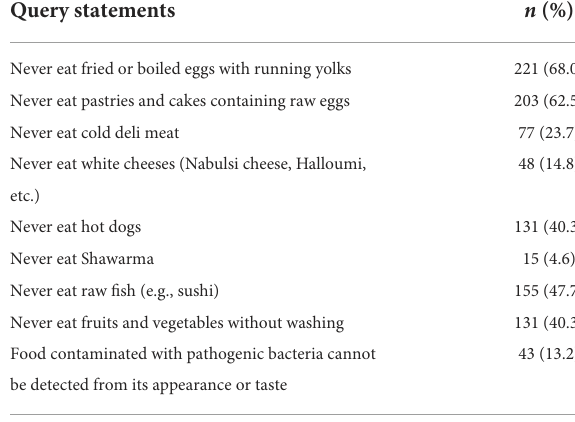
TABLE 6 Query statements and responses a of “food consumption and safety” domain ( n =